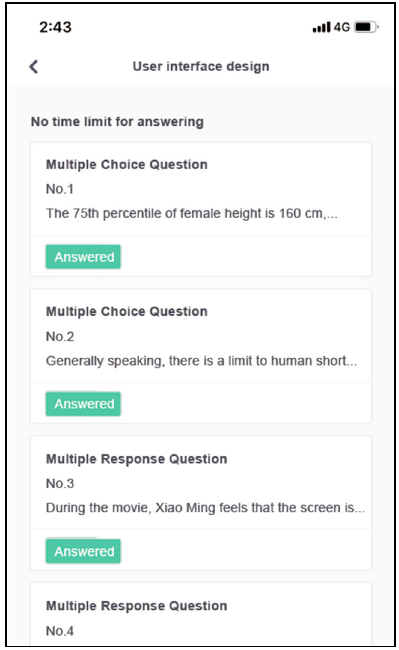
Figure 6. Promising experimental sample A.